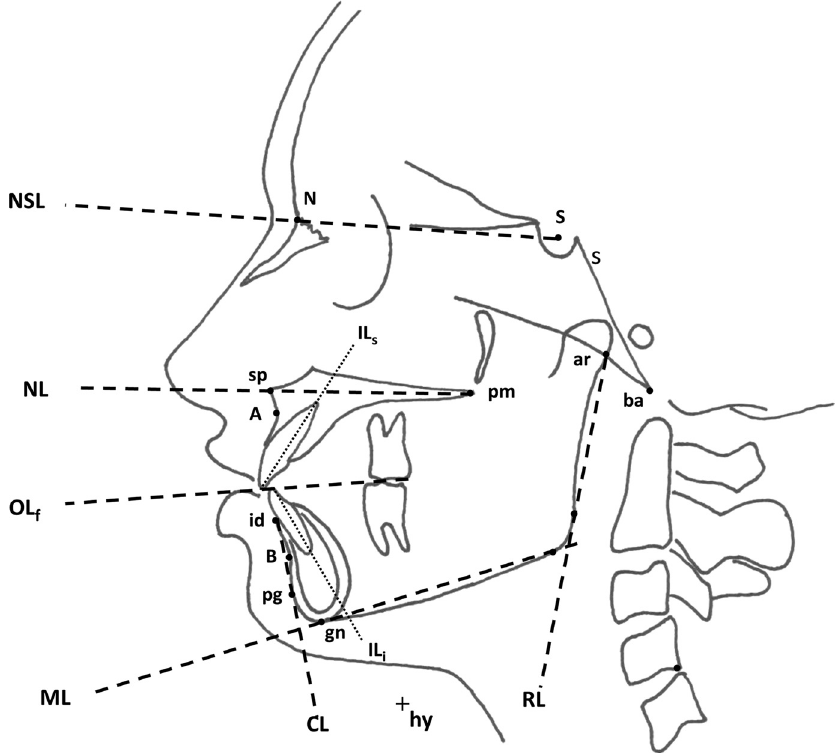
Figure 1. Reference points and lines used according to Solow and Tallgren 18 (Table